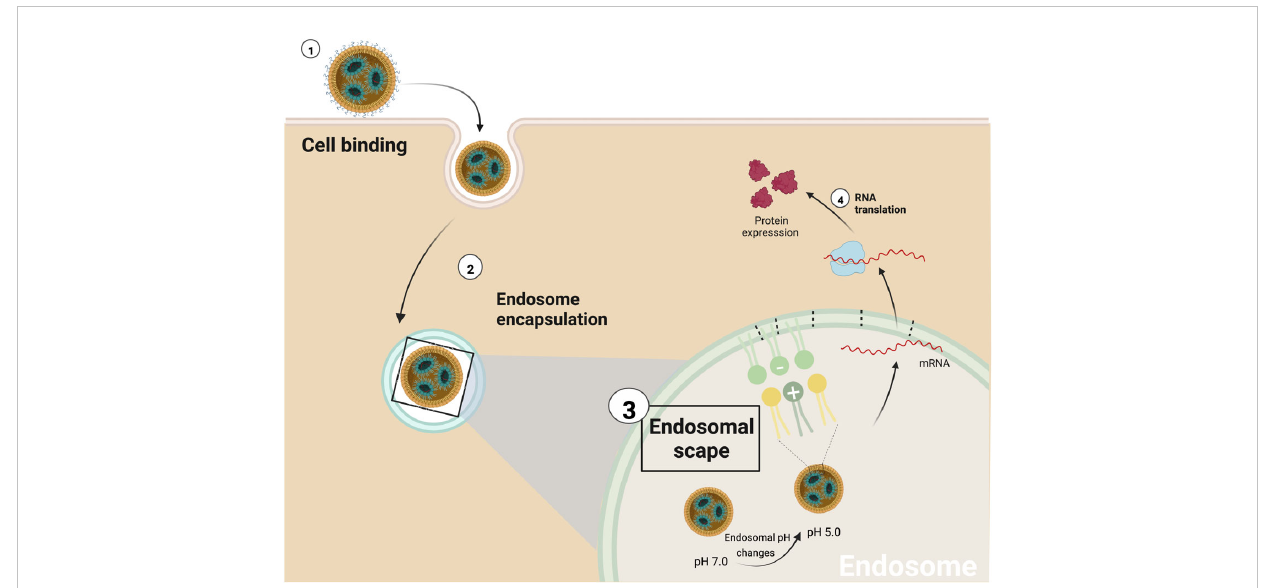
FIGURE 4 Schematic representation of endosomal scape mediated by iLNPs. 1) The fi rst interaction between iLNPs and the target cell activates the endocytosis process, and 2) subsequently, the nanocarrier is encapsulated by the endosome. 3) As proton pumps reduce the pH of the endosome, the ionizable cationic lipid becomes progressively protonated (positively charged). As a result, it can interact with the endosome ’ s membrane anionic lipids to produce non-bilayer structures, disrupting the endosomal membrane and the iLNP structure and 4) releasing the mRNA into the cell